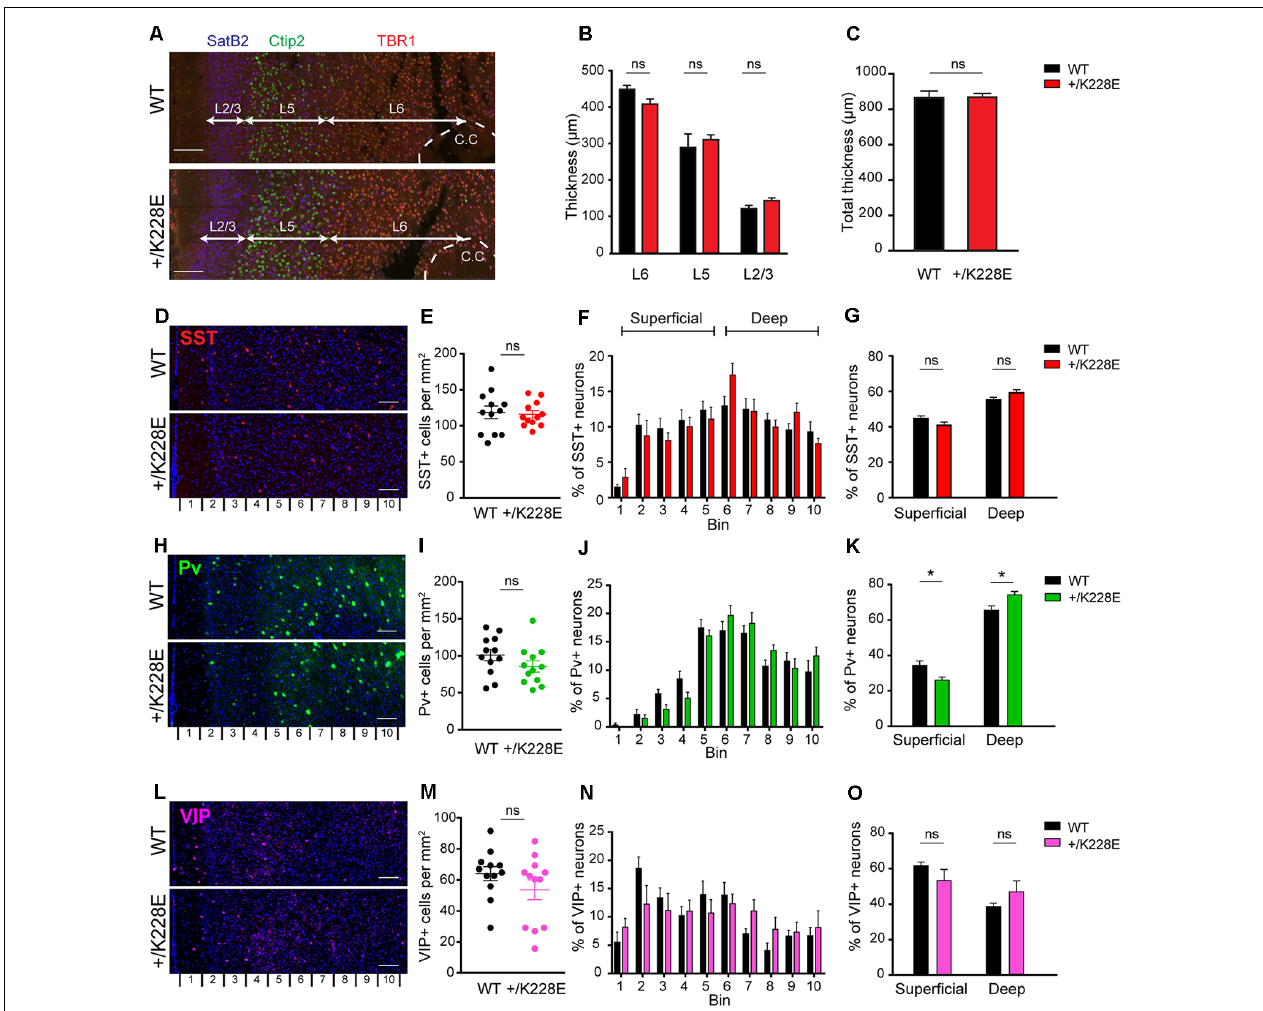
FIGURE 5 | Altered numbers of parvalbumin (Pv)-positive interneurons in superficial and deep cortical layers, but normal cortical thickness in the Tbr1 + / K228E mPFC. (A–C) Normal thickness of the whole cortex and individual cortical layers in the prelimbic region of the mPFC in Tbr1 + / K228E (HT) mice (P5), as indicated by the thickness of total (C) and individual (B) cortical layers. Layers were marked by immunofluorescence staining: layer2/3, SatB2; layer 5/6, Ctip2; and layer 6, TBR1. n = 3 sections from three mice, ns, not significant, Mann–Whitney test. Scale bar, 100 µ m. (D–G) Normal total number of somatostatin (SST)-positive neurons in the prelimbic region of the mPFC of Tbr1 + / K228E mice (HT; 3 months), as indicated by the number of SST-positive cells across the total cortical depth (bin 1–10; lower numbers correspond to upper layers) and the sum of superficial and deep cortical layers (bins 1–5 and 6–10 for superficial and deep layers, respectively). n = 12 sections from three mice for WT and HT, ns, not significant, two-way ANOVA with Sidak’s multiple comparison test (for SST-positive cells in superficial or deep layer) and Student’s t -test (total SST-positive cells). Scale bar, 100 µ m. (H–K) Decreased numbers of Pv-positive neurons in superficial layers and increased numbers in deep cortical layers in the prelimbic region of the mPFC of Tbr1 + / K228E (HT) mice (3 months). n = 12 sections from three mice for WT and HT, ∗ P < 0.05, ns, not significant, two-way ANOVA with Sidak’s multiple comparison test (for PV-positive cells in superficial or deep layers) and Student’s t -test (total PV-positive cells). Scale bar, 100 µ m. (L–O) Normal total number of vasoactive intestinal peptide (VIP)-positive neurons in the prelimbic region of the mPFC of Tbr1 + / K228E (HT) mice (3 months), as indicated by the number of VIP-positive cells across the total cortical depth. n = 12 sections from three mice for WT and HT, ns, not significant, two-way ANOVA with Sidak’s multiple comparison test (for VIP-positive cells in superficial or deep layer) and Student’s t -test (total VIP-positive cells). Scale bar, 100 µ